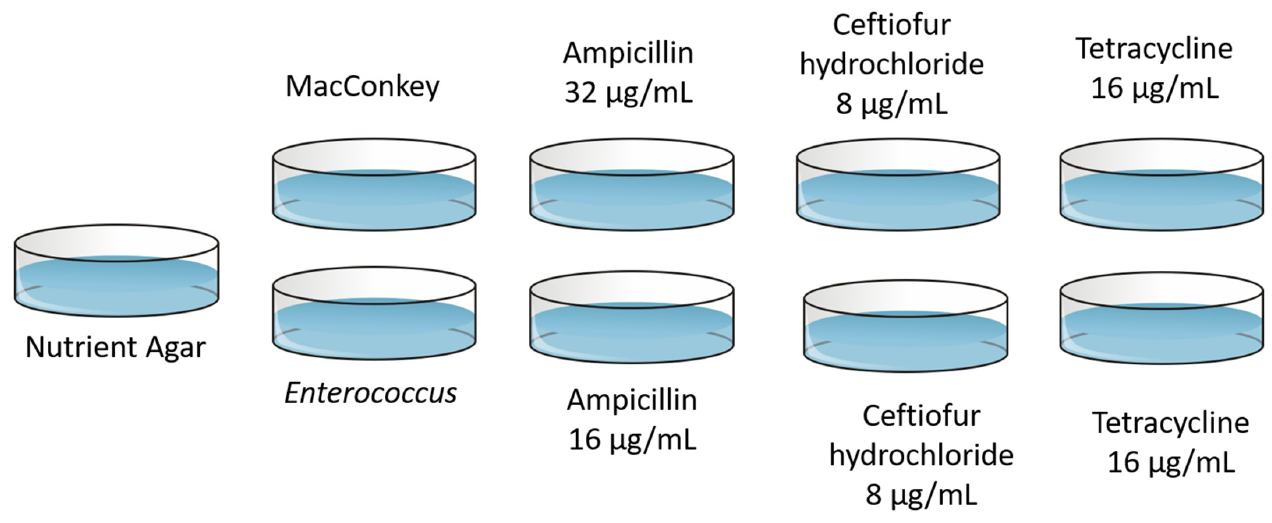
Figure 1. The experimental design quantifying E. coli or Enterococcus on MacConkey agar or m-Enterococcus agar, respectively, and media containing tetracycline, ceftiofur hydrochloride or ampicillin. Nutrient agar was utilized as the positive control. Table 1. The interpretive categories and MIC breakpoints ( µ g/mL) for both E. coli and